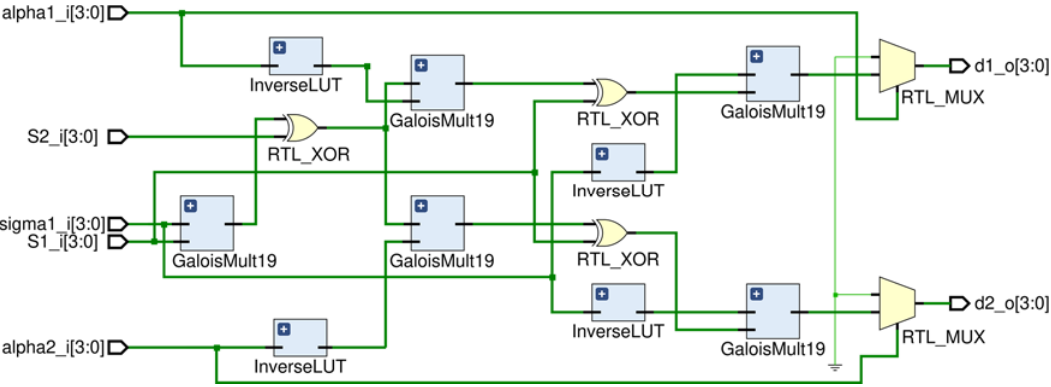
Figure 6. Register transfer level (RTL) result of the Forney method for the RS(15,11) configuration.